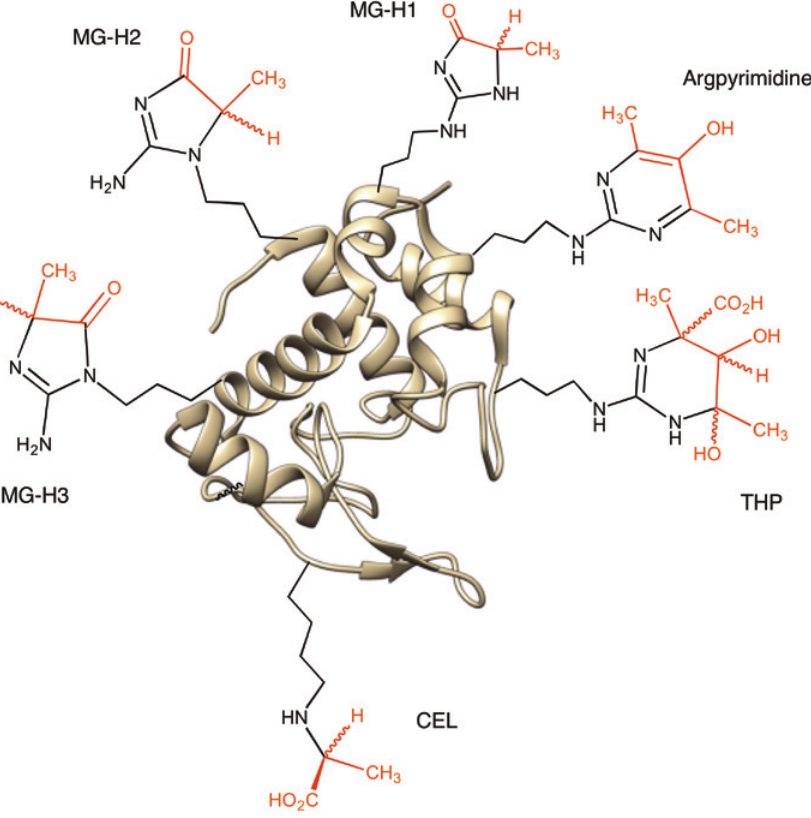
Figure 10: Chemical structures of identified MG-arginine and MG-lysine side chain protein adducts formed from advanced glycation end- product (AGE) formation. Atoms colored in red originate from